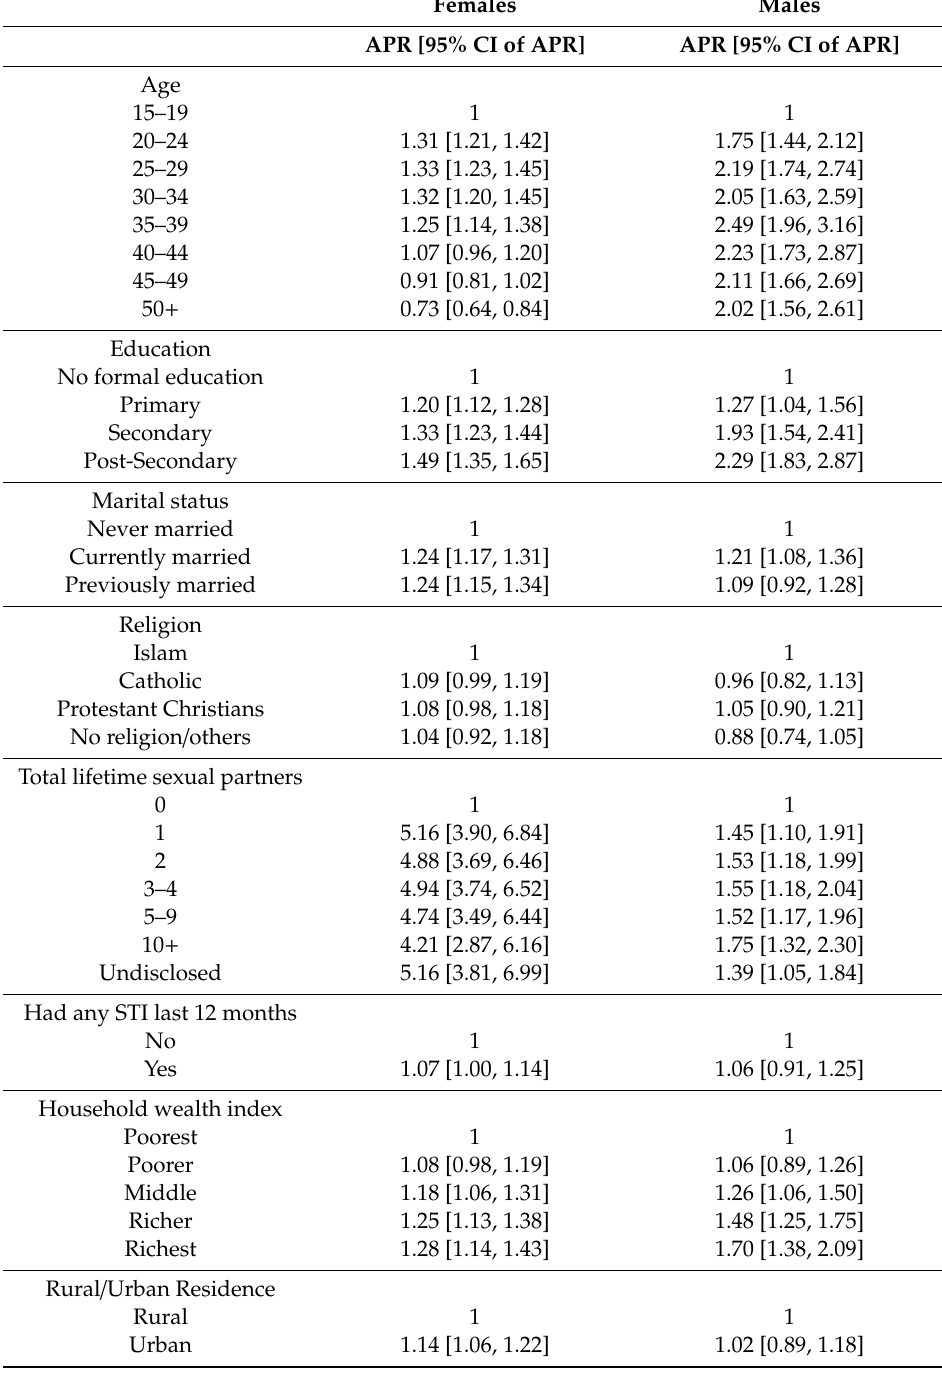
Table 4. Complex sample Poisson regression results of the predictors of having ever tested for HIV stratified by